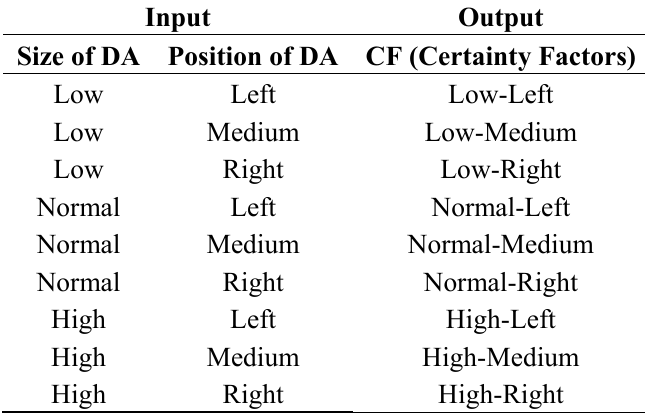
Table 2. The rules of the fuzzy logic system for the adaptive